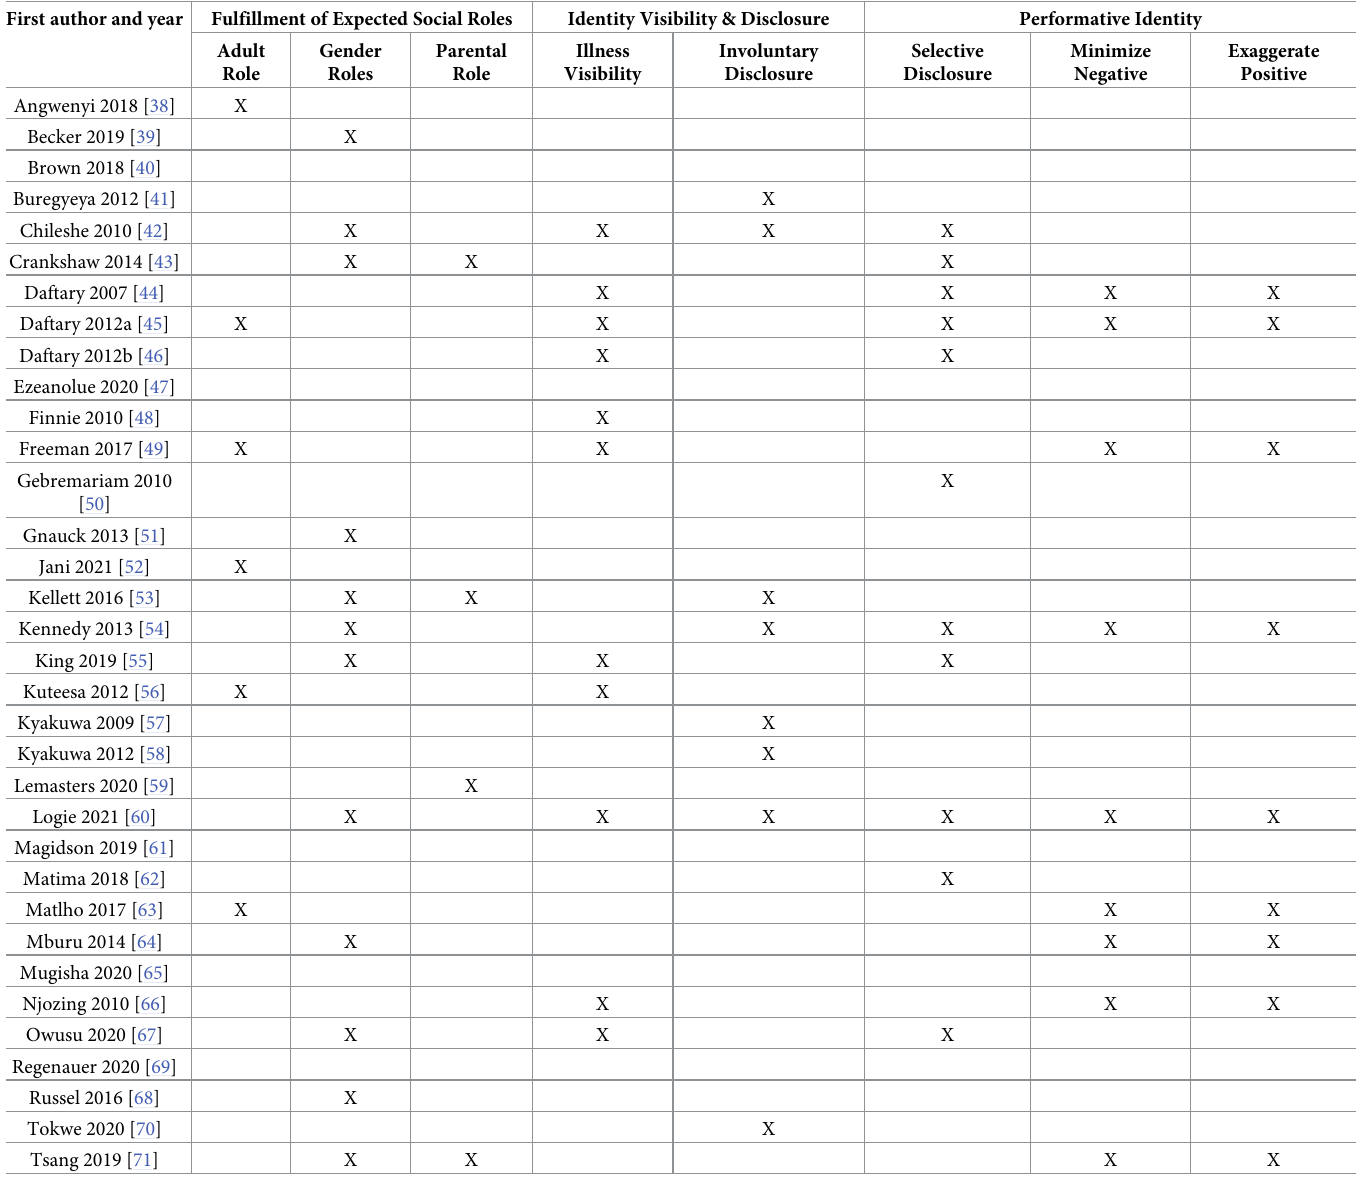
Table 3. Thematic results by included